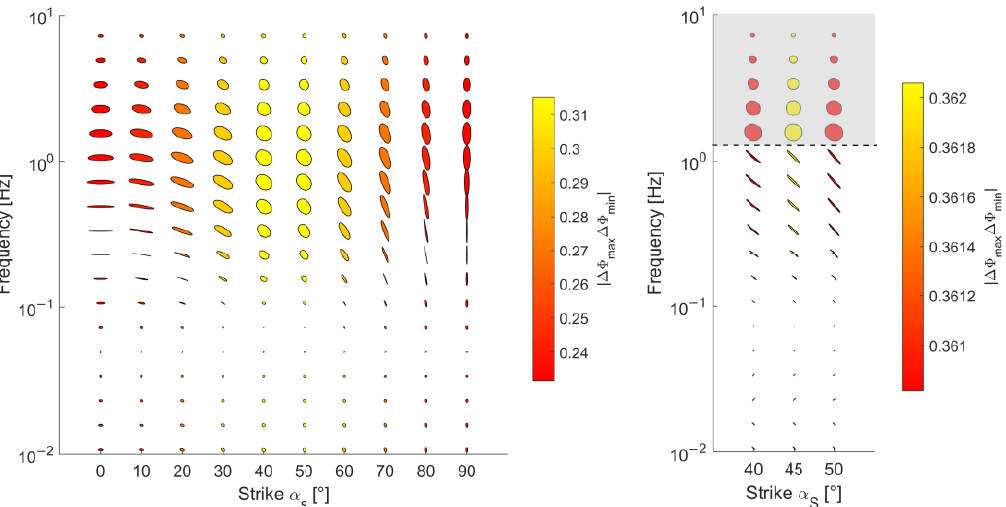
Energies 2022 , 15 , x FOR PEER REVIEW